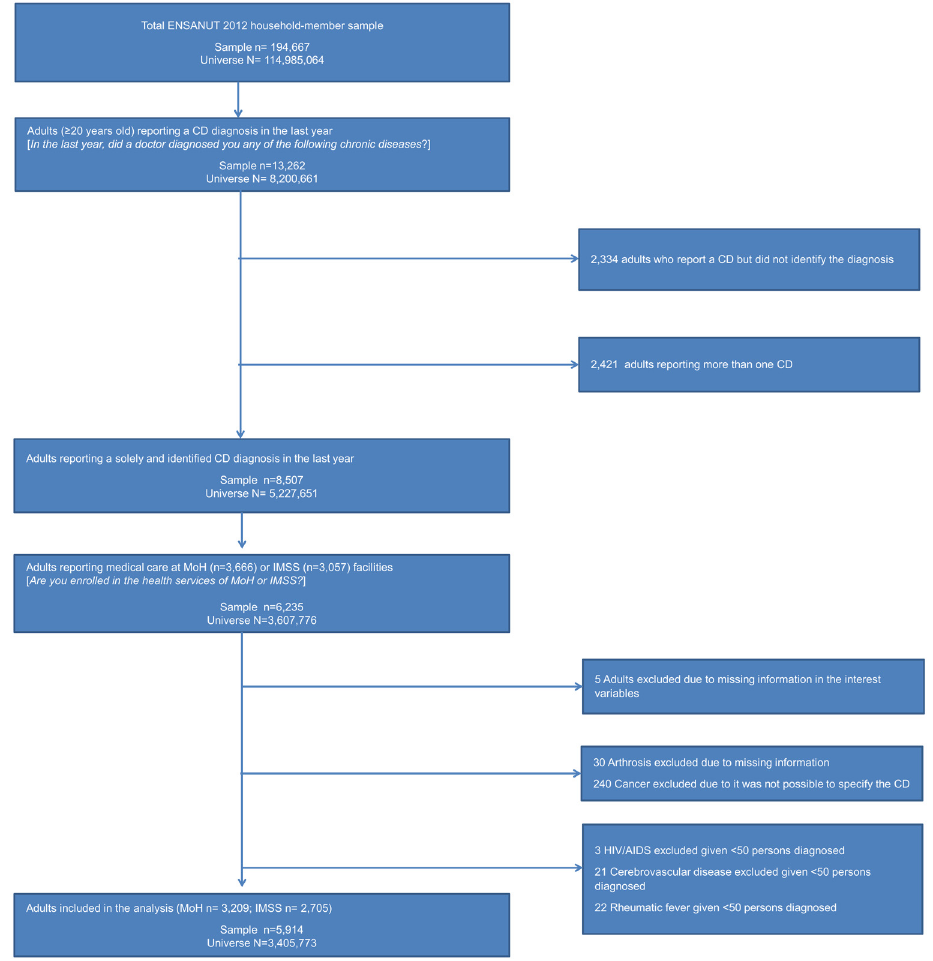
Fig 1. Filters applied to the original data set to obtain the analysis